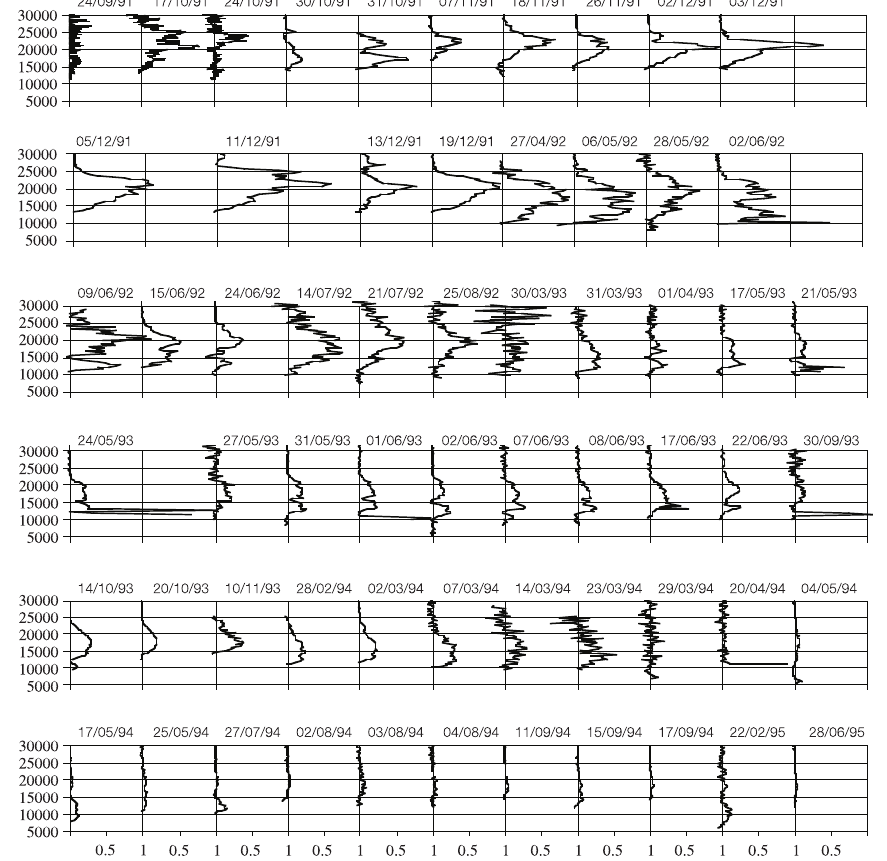
Fig. 2. Vertical profi les of the aerosol backscattering coeffi cient at 351 and 355 nm for 61 selected nights of measurements in the period September 1991-June 1995. Data are expressed in units of 10 - 6 m –1 sr –1